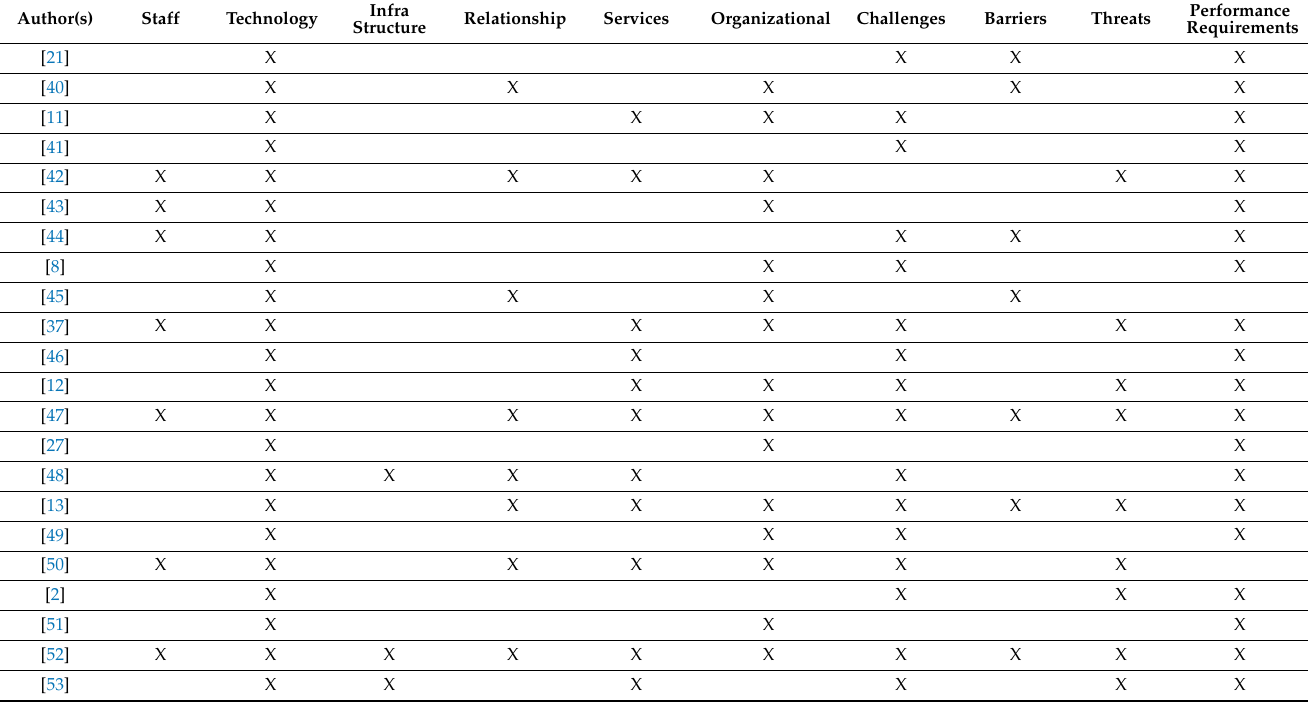
Table 3. Concept categories extracted from the